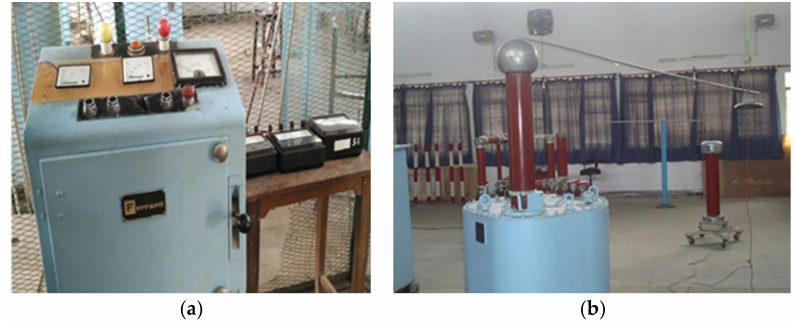
Figure 1. Experimental setup. ( a ) Control panel; ( b ) Transformer